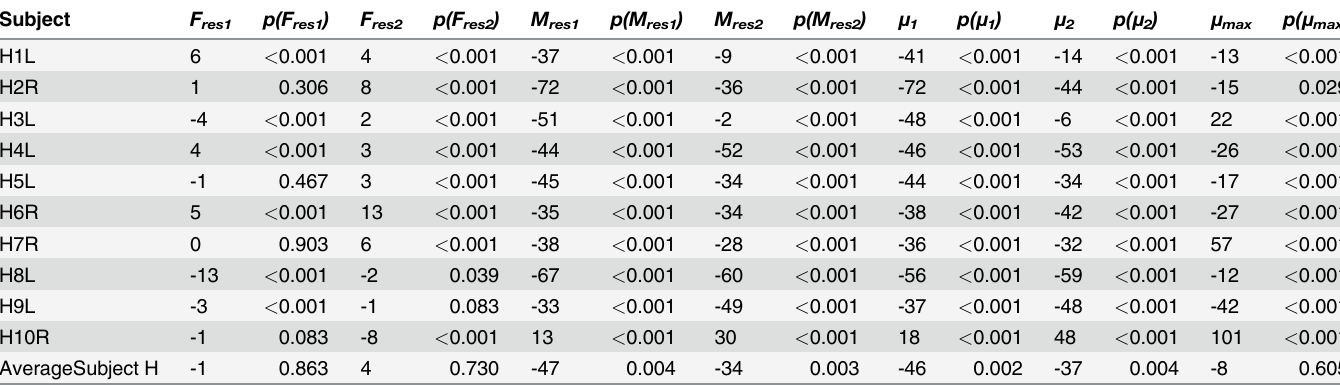
Table 4. Load and friction